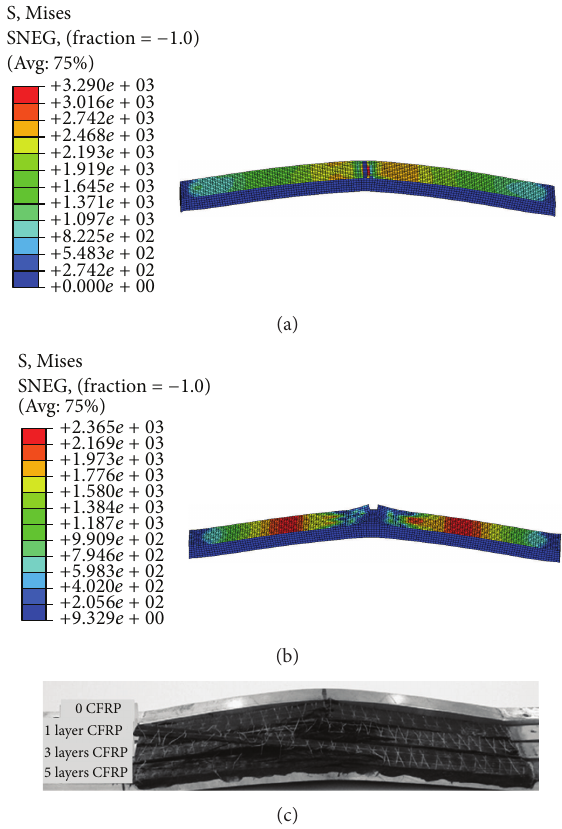
Figure 15: (a) Fiber rupture modeled by FEA. (b) Debonding and fiber rupture modeled by FEA. (unit: MPa) (c) Photos of the impulsive beam test results